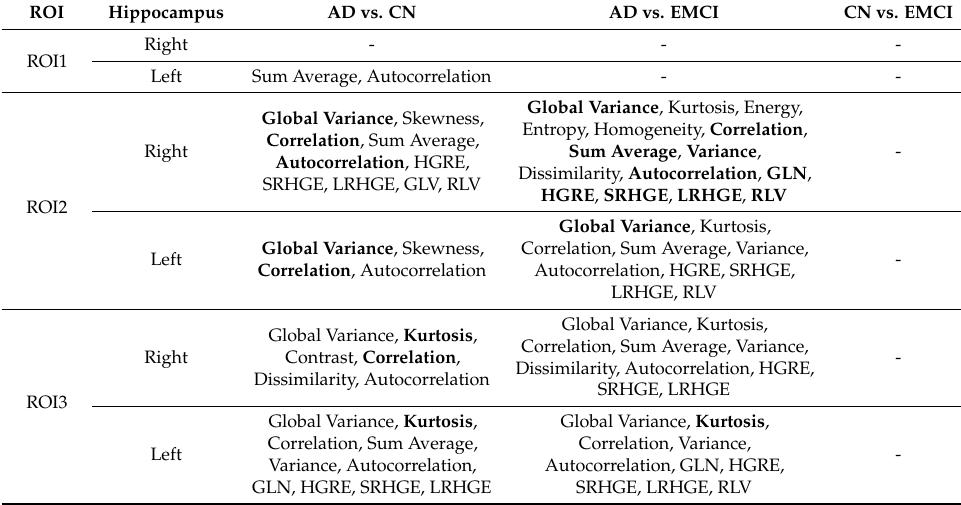
The subset of features highlighted in bold were also statistically significant when applying the Bonferroni correction. Table A2. List of statistically significant texture parameters in the 3D texture analysis (spherical ROIs) when performing the MWW test with BH correction for comparisons between individual groups.